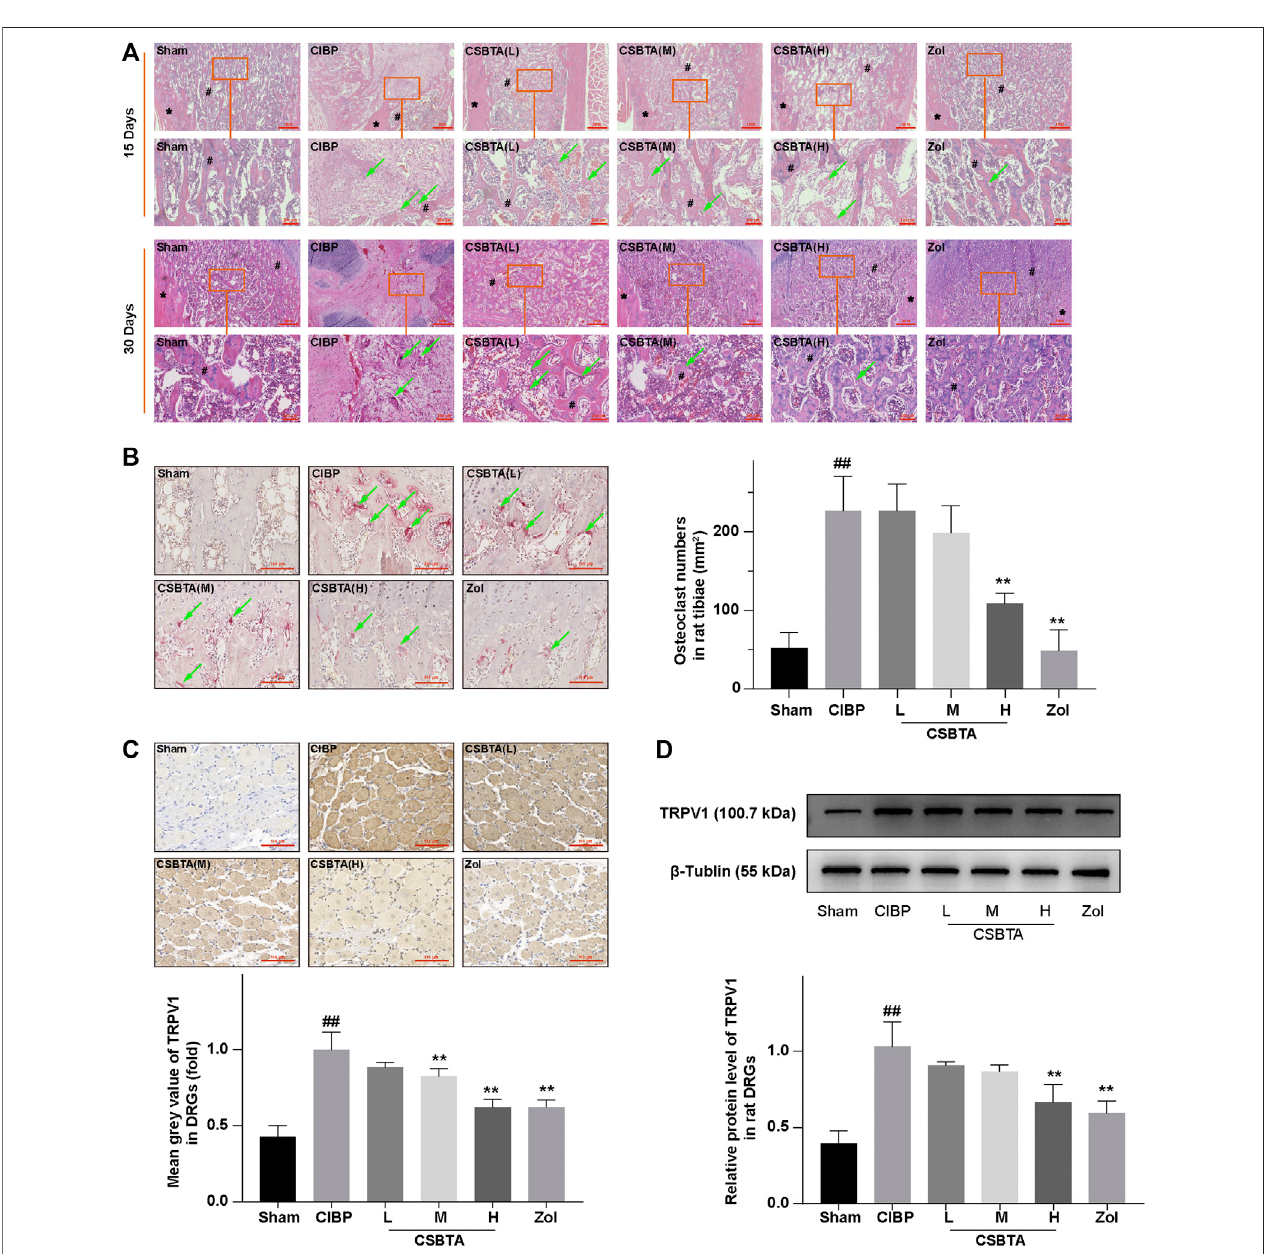
FIGURE2| CSBTA ameliorated cancercell-induced osteolysis and alleviated CIBP invivo . (A) Decalci fi edsections from rattibia wereprocessed forHE stainingat 15-days and 30-days after tumor cellinoculation.# marked thetrabecular bone and * marked thecortical bone, thegreen arrow indicatedosteoclast.Scale bar (cid:2) 1 mm (low magni fi cation) or 200 μ m (high magni fi cation). (B) Decalci fi ed sections from rat tibiae were processed for TRAP staining at 30-days after tumor cell inoculation, and osteoclasts were counted and analyzed ( n (cid:2) 5). Scale bar (cid:2) 100 µm. (C) Immunohistochemical analysis of the spread and expression of TRPV1 in DRGs of rats at 30-days after tumor cell inoculation ( n (cid:2) 3). Scale bar (cid:2) 100 µm. (D) Western blot detection and densitometry quanti fi cation of TRPV1 expression in DRGs of rats at 30- days after tumor cell inoculation ( n (cid:2) 3). Data was presented as means ± SD. # p < 0.05, ## p < 0.01 vs. the Sham group. * p < 0.05, ** p < 0.01 vs. the CIBP group.